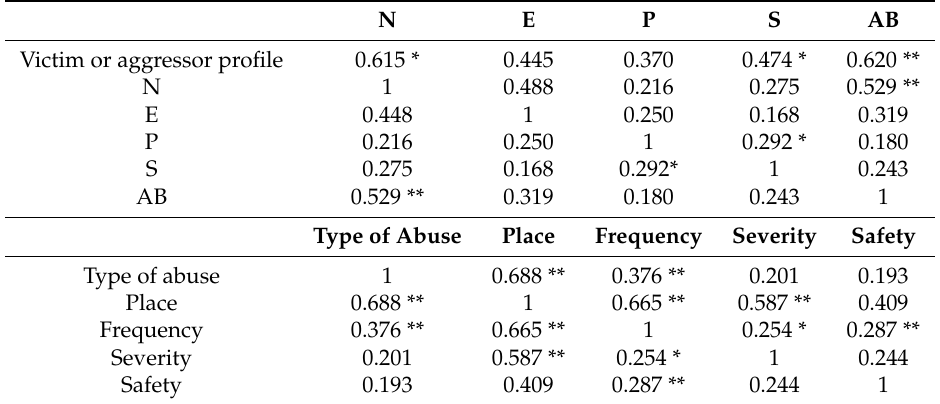
Table3. Correlationsofpersonalityvariables, accordingtotheEPQ-Jquestionnaire, andvariablesrelated to the characteristics of the perception of abuse, according to the Bull-S test, with the characteristics of the phenomenon of bullying and the rest of variables used in the